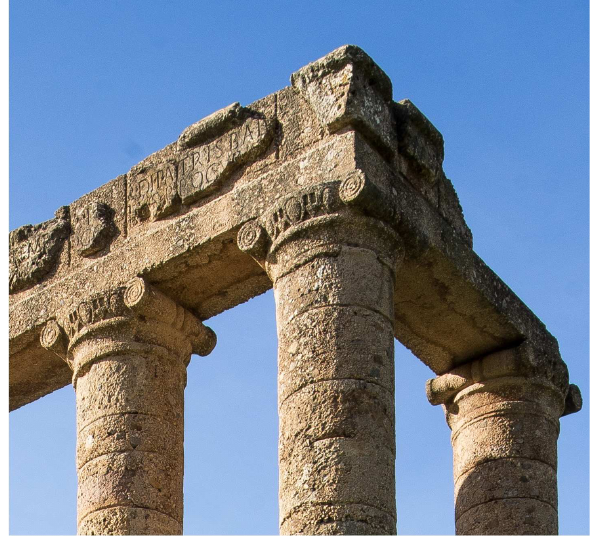
Figure 4. Detail on the three Ionic capitals of the southeast corner of the